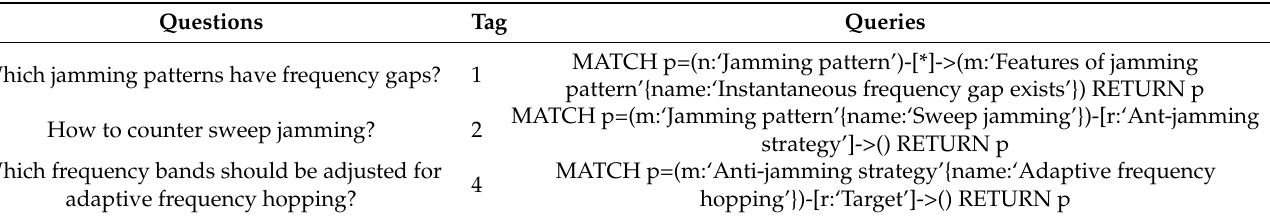
Table 2. Questions and corresponding query template examples.